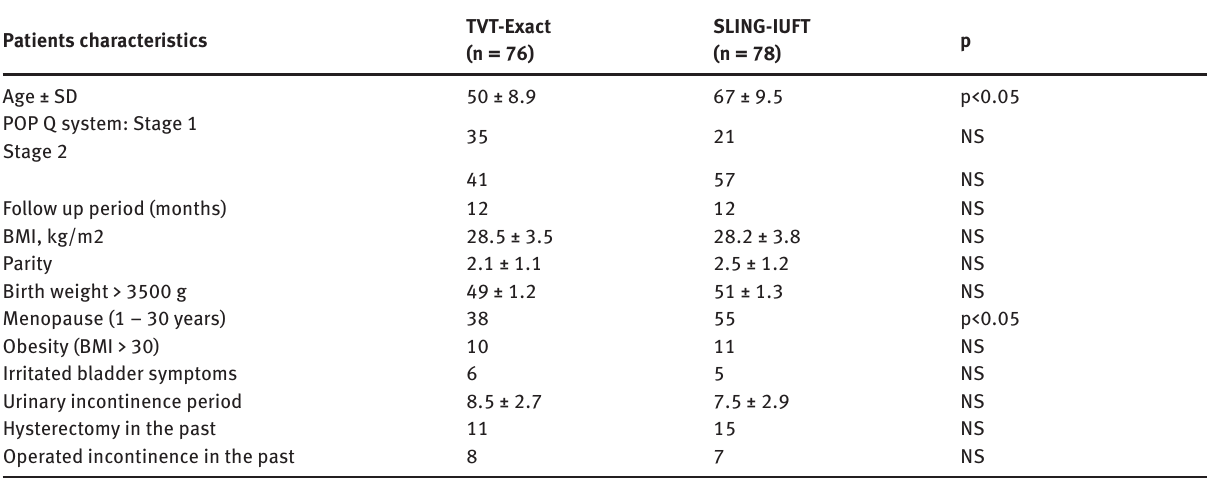
Table 1: Patients characteristics